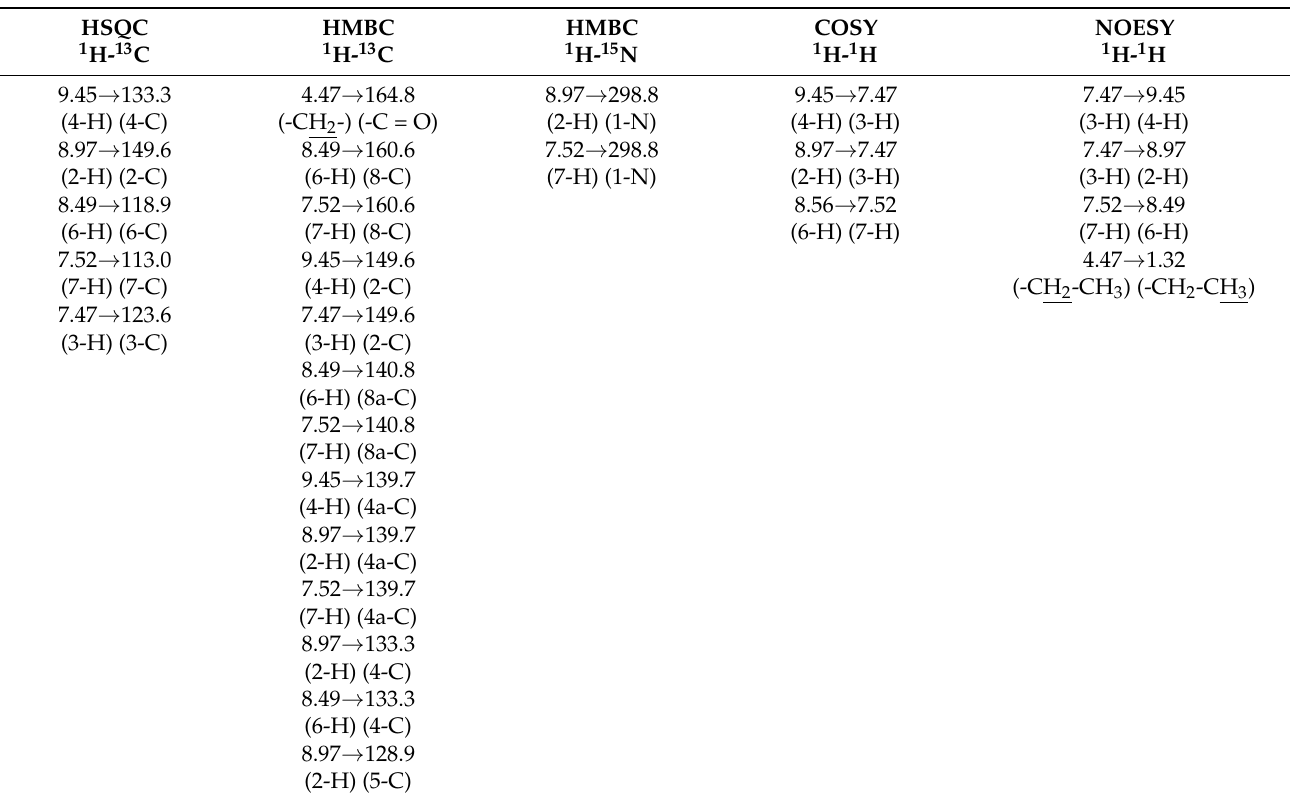
Table 1. Experimental NMR data * for the compound (3)